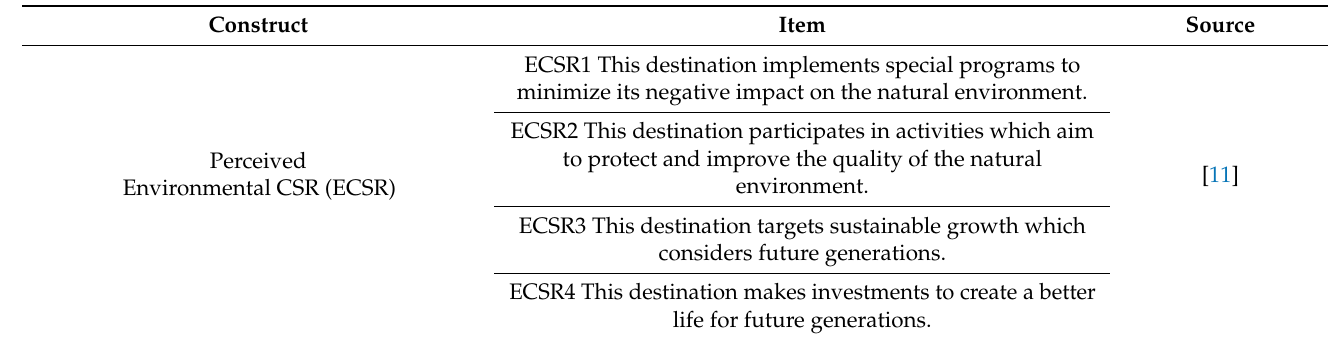
Table A1. Detailed measurements of all